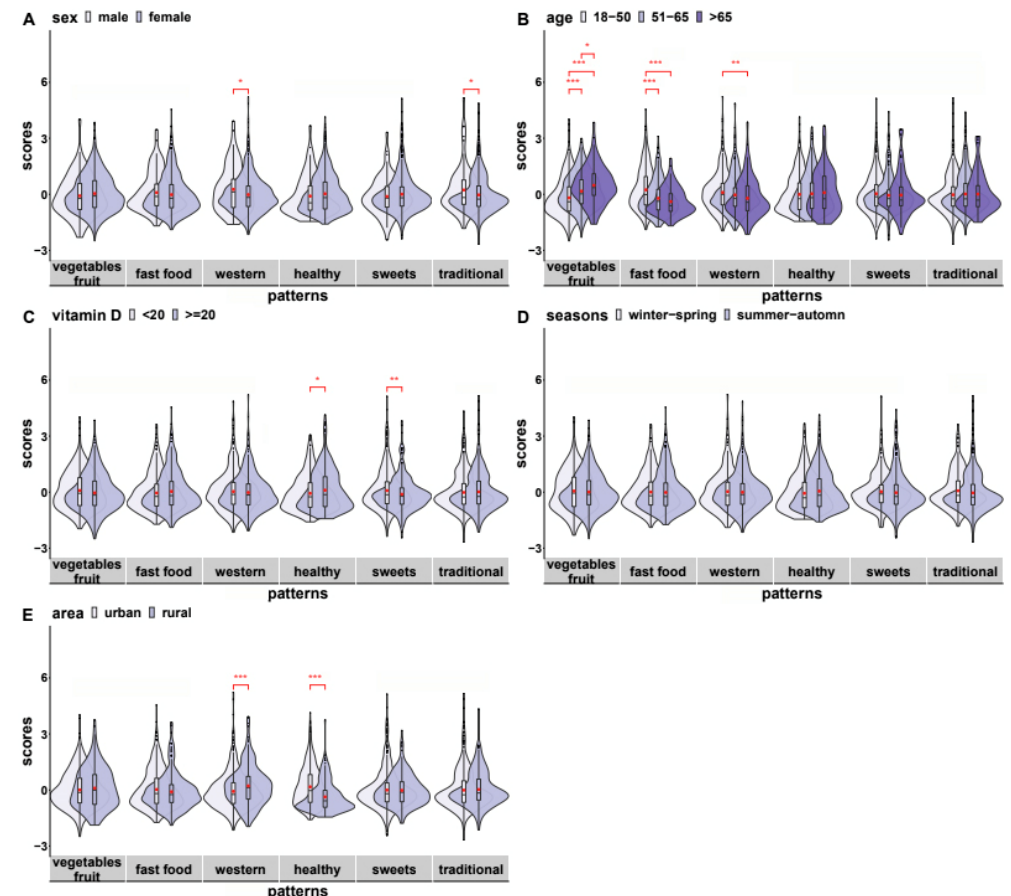
Figure 1. Distribution of scores derived from PCA (principal component analysis) among; ( A ) sex, ( B ) age groups, ( C ) serum vitamin D status, ( D ) season of blood sampling, and ( E ) area of residence. * p < 0.05, ** p < 0.01, *** p < 0.001, • mean, ₋ median. Males were more engaged in the ‘Western’ pattern than females. This di ff erence remained after adjustment for age (B = 0.255, p = 0.032) as well. Moreover, males had better compliance to the ‘traditional’ pattern after adjustment for age (B = 0.258, p =